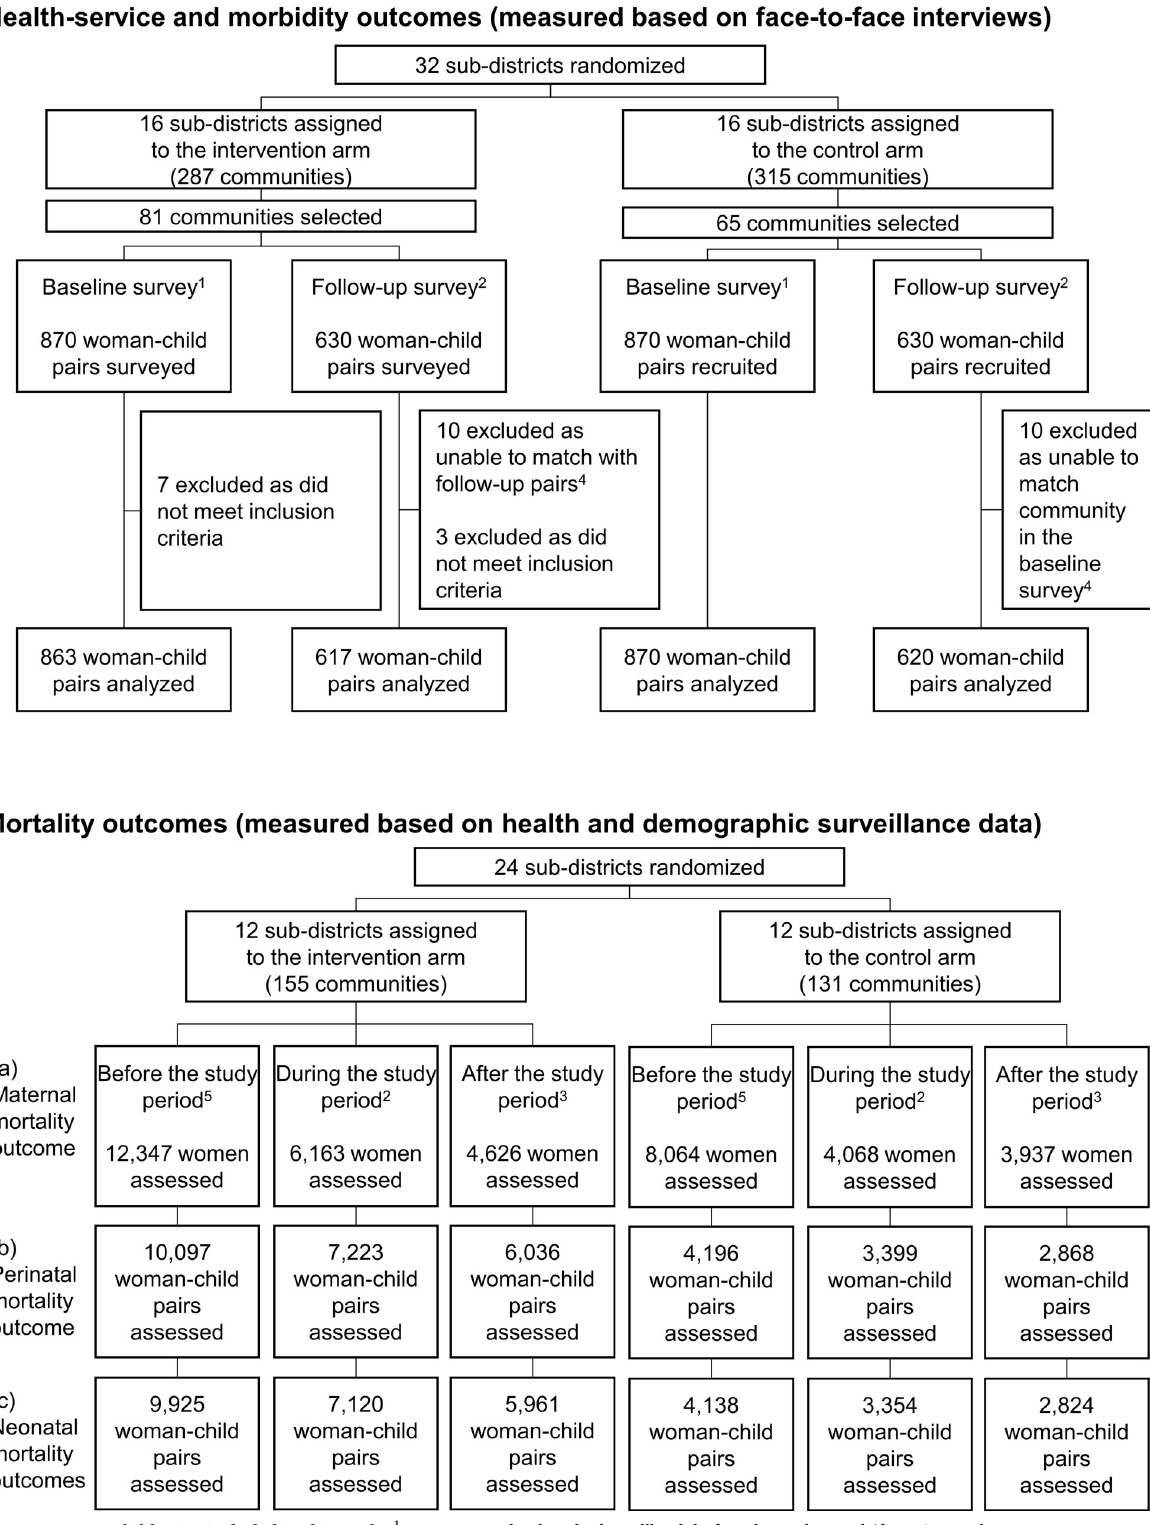
Fig 1. Woman–child pairs included in this study. 1 Women gave birth or had a stillbirth before the trial period (from September 1, 2012 to June 30, 2014). 2 Women gave birth or had a stillbirth during the trial period (from October 1, 2014 to December 31, 2015). 3 Women gave birth or had a